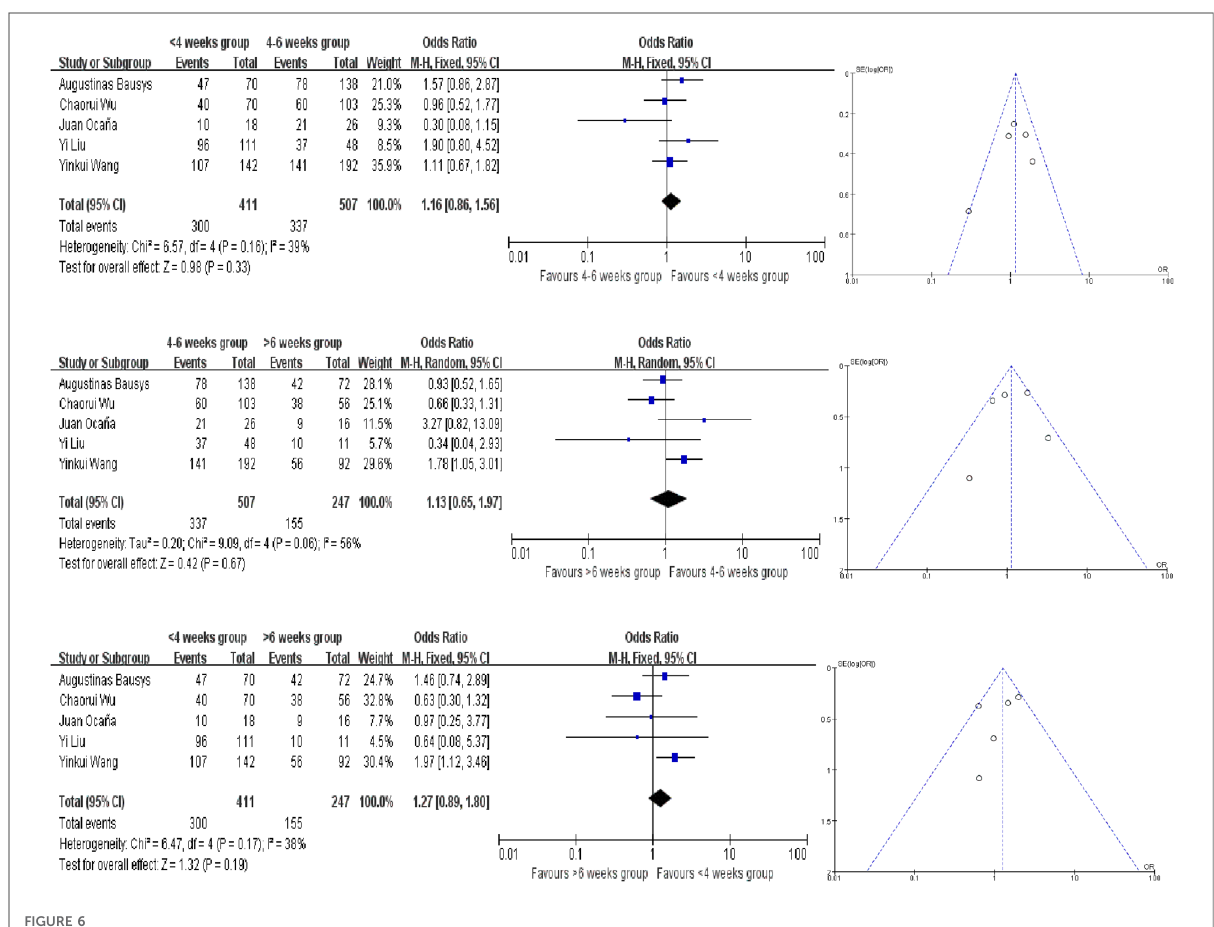
FIGURE 6 Forest plot and funnel plot for 3-year OS rates meta